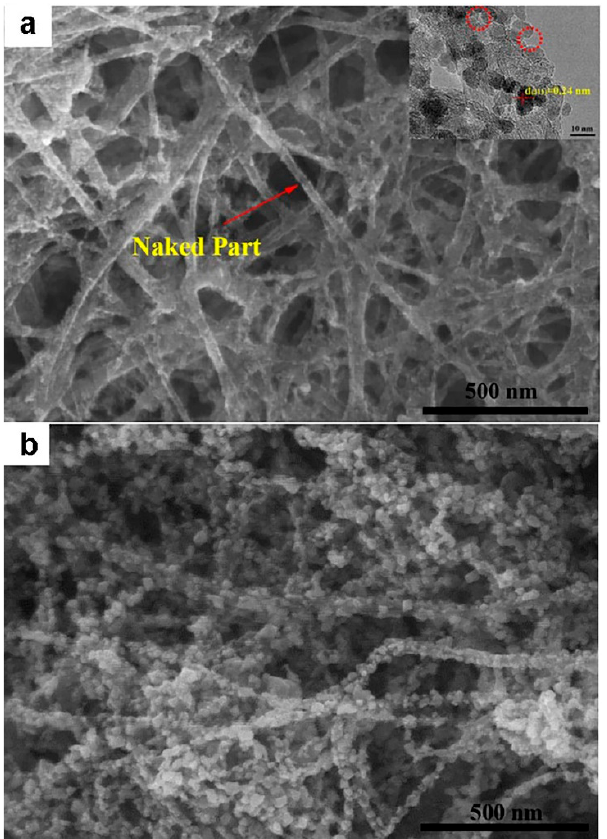
Figure 4. SEM images of different materials, ( a ) NiCo 2 O 4 /CNT-12, The red dotted circles show the interspaces existing between NiCo 2 O 4 nanoparticles; ( b ) NiCo 2 O 4 /CNT-24. Reproduced with permission from [64]. Copyright 2016, Wiley.